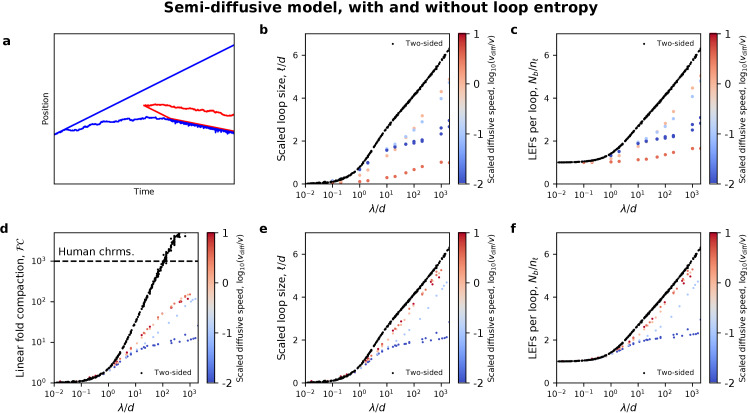
Loop sizes and LEF nesting explain the ineffectiveness of the semi-diffusive model.(a) Example trajectory of a semi-diffusive LEF (blue) that is ratcheted open by another LEF (red) that binds within the extruded loop. (b) Mean loop sizes, ℓ, are small in the semi-diffusive model because loop growth is opposed by entropy. (c) Consequently, the number of LEFs per loop, which quantifies LEF nesting, remains small. (d) In a semi-diffusive model that ignores the effects of polymer conformational entropy, a higher degree of linear compaction, FC, can be obtained, but FC < 1000 for λ/d < 1000. (e) This can occur due to the growth of larger loops, which (f) facilitates LEF nesting, and thus Brownian ratcheting. Two-sided extrusion data is shown in black in (b-f) for comparison.